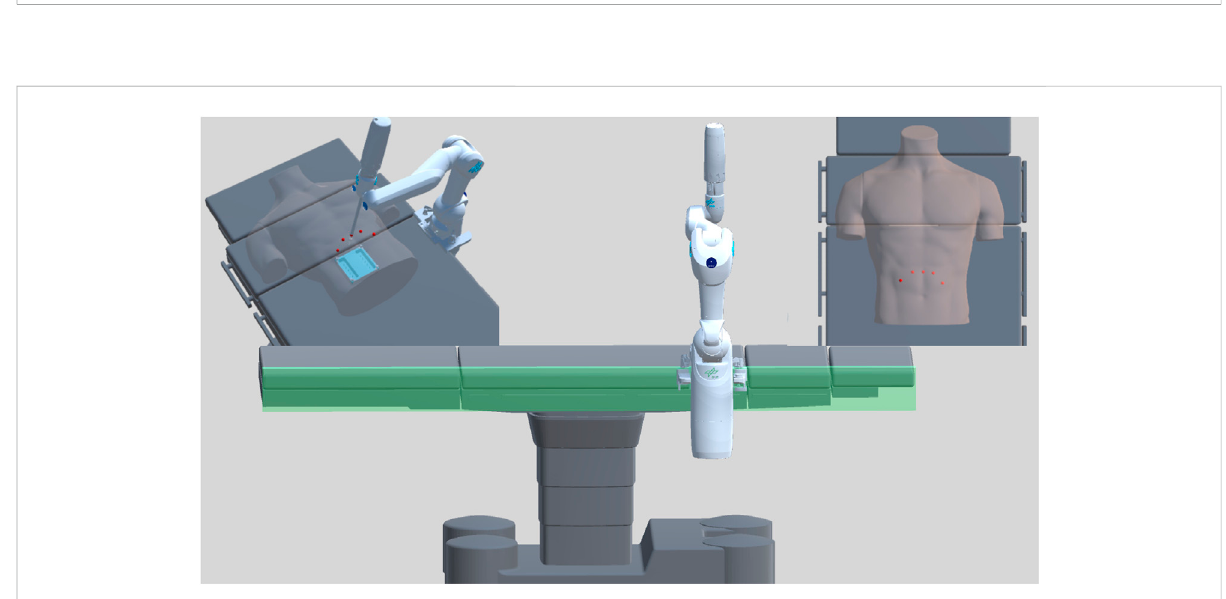
FIGURE 9 Robot-assisted laparoscopy. Area for possible robot base placement positions (highlighted in green), access point placement (highlighted in red), and the task as a desired area of motion on the surgical training pad (highlighted in